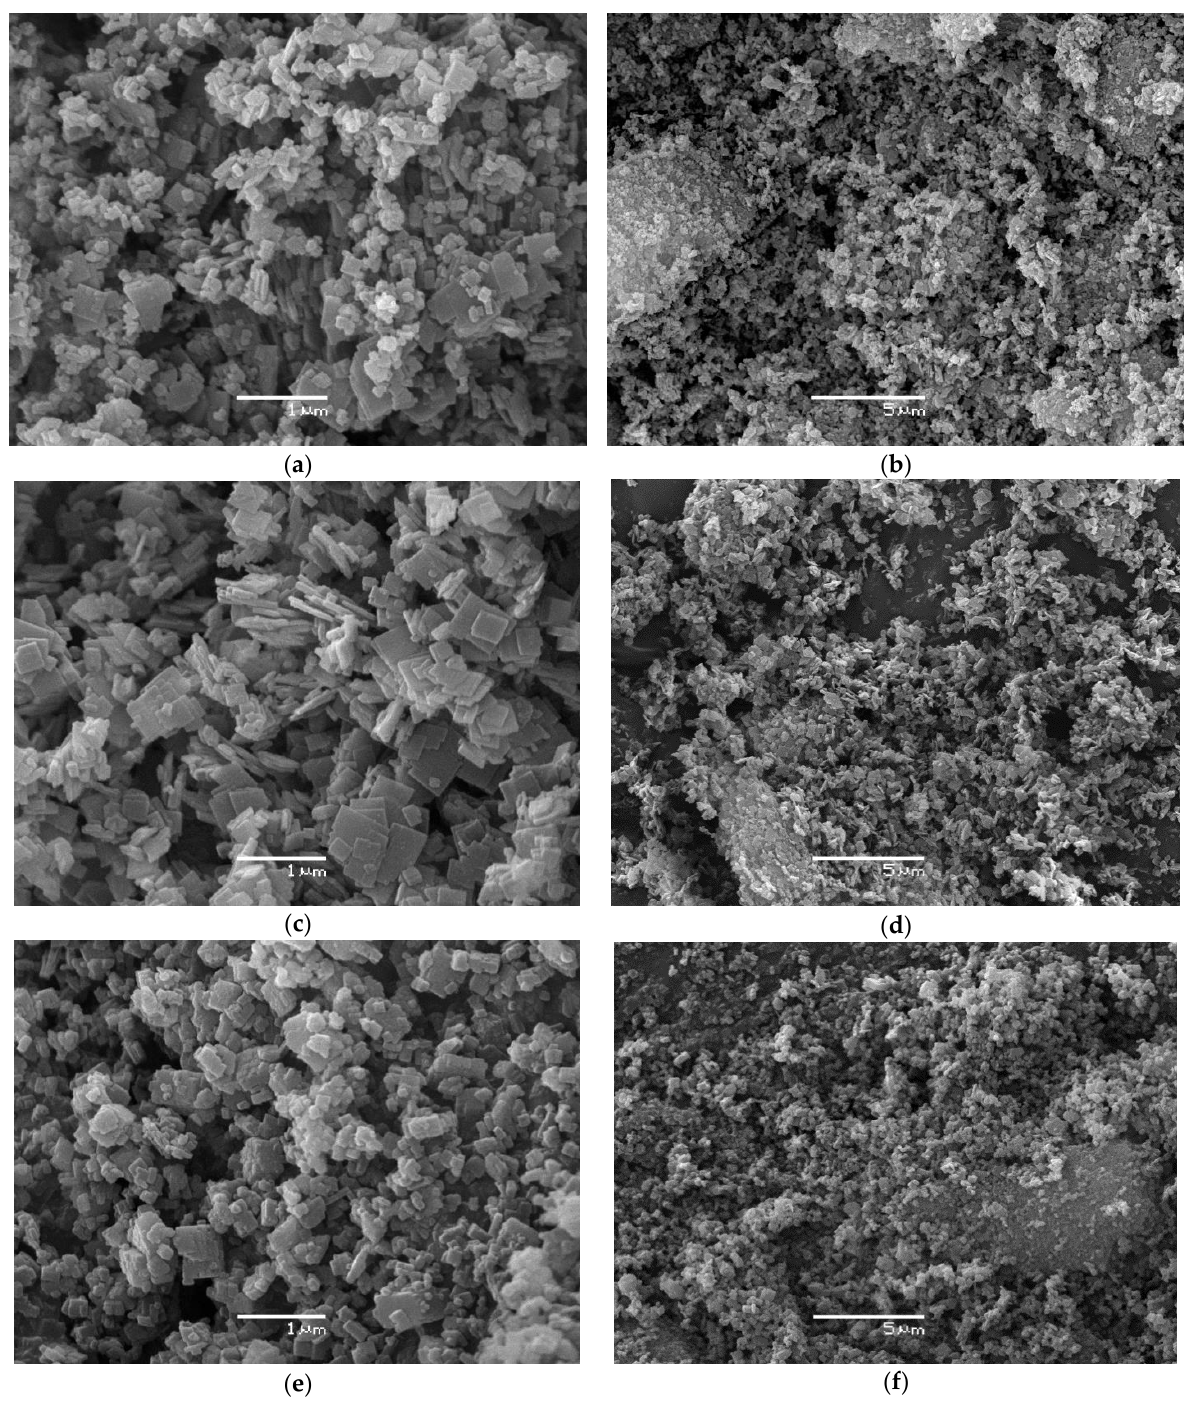
Figure 6. SEM images of SAPO-34 crystals: ( a , b ) SAPO-34 – 5h; ( c , d ) SAPO-34 – 24h; ( e , f ) SAPO-34 – B – 5h.